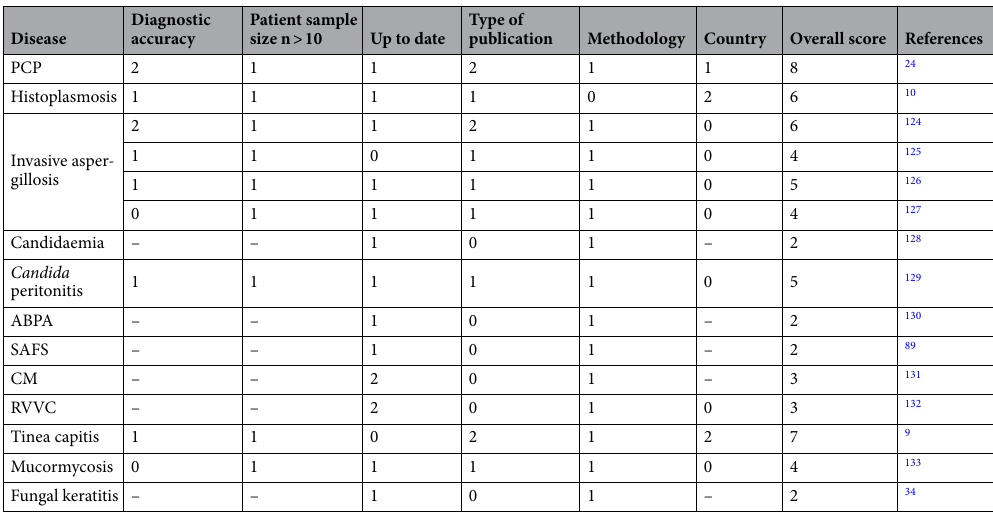
Table 3. Modified GRADE score for the papers used for estimating burden of fungal diseases in Zimbabwe. CM Cryptococcal meningitis, PCP Pneumocystis pneumonia, CPA chronic pulmonary aspergillosis, ABPA